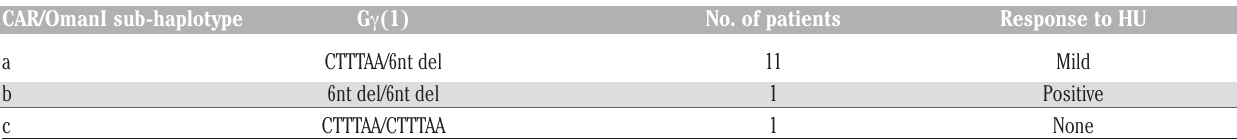
Table 6. The different genotypes observed at the G- g promoter (SNP1) among CAR/OmanI patients, suggesting the existence of three different sub-haplotypes (a, b and c). CAR/OmanI sub-haplotype